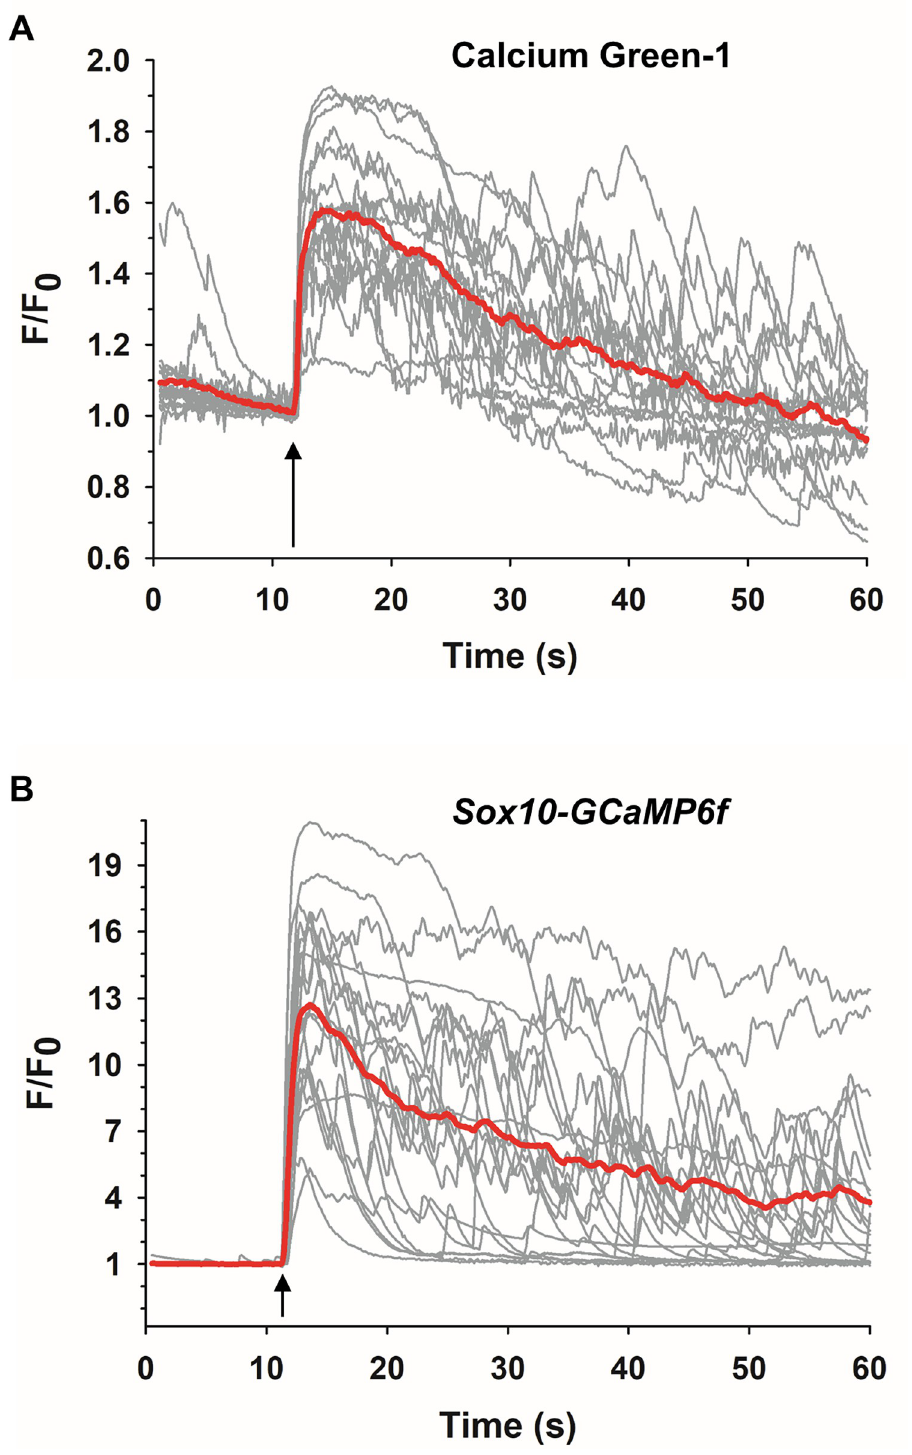
Fig 6. Comparison of Ca 2+ responses in wt and GCaMP-expressing mouse ACC exposed to a 5 ns pulse. (A) Ca 2+ responses evoked by a 5 ns, 8 MV/m pulse (arrows) in wt dye-loaded ACC ( n = 3, c = 16) and (B) in GCaMP6f- expressing ACC ( n = 3, c = 20). Traces show individual cell responses together with the averaged response (red lines). In (A), photobleaching is evident by the drop in fluorescence intensity below F/F 0 = 1.